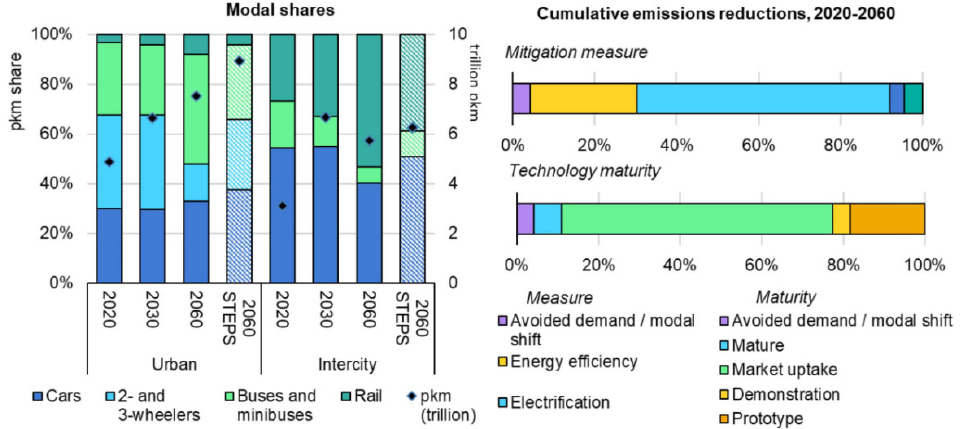
Figure 1. Measures and technological progress of CO 2 emissions reductions